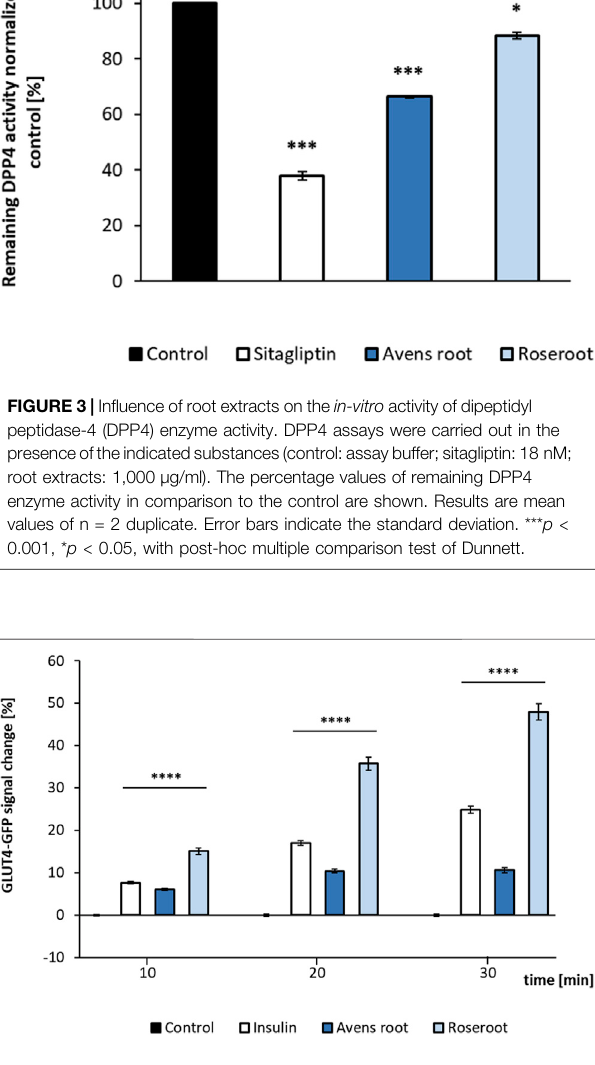
FIGURE 4 | GLUT4-GFP translocation response to root extracts and insulin.GLUT4-myc-GFPcellswereseededin96-wellplates(40,000cellsper well), grown overnight followed by 3 h of starvation in Hank ’ s balanced salt solution (HBSS) buffer. Subsequently, the cells were stimulated by the addition of insulin (100 nM) or root extracts (1:10,000) dissolved in Krebs Ringer phosphate HEPES buffer (control) for 10 – 30 min. Results of two testing days are summarized. Control (n (cid:2) 88); Insulin (n (cid:2) 99); Avens root (n (cid:2) 96); Roseroot (n (cid:2) 72 – 83). Error bars indicate the standard error of the mean. **** p < 0.0001, with a signi fi cant change to control.